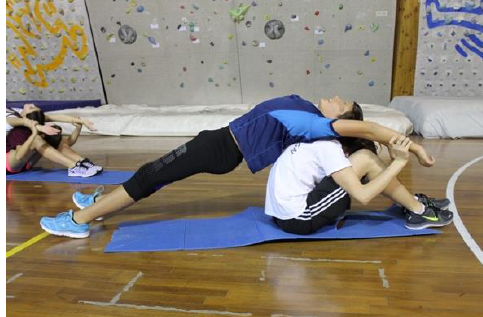
Figure 3. Final position of the spine mobilization exercise.